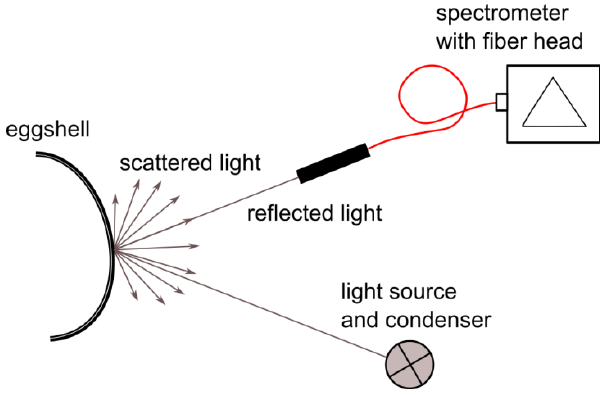
Figure 1. Scheme of the laboratory setup for spectral data acquisition.